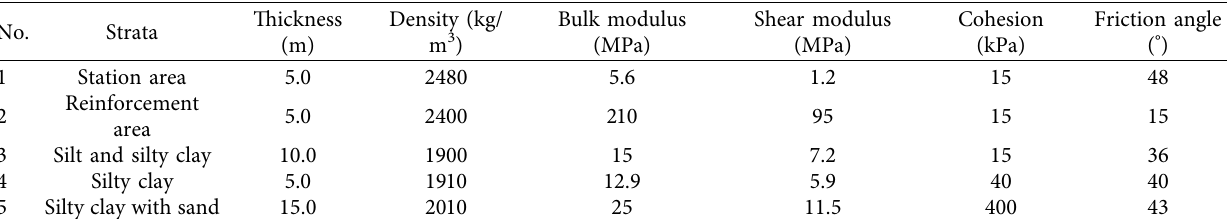
Figure 6: Schematic diagram of the model. (a) Three-dimensional diagram. (b) Strata distribution Table 2: Mechanical parameters of strata.